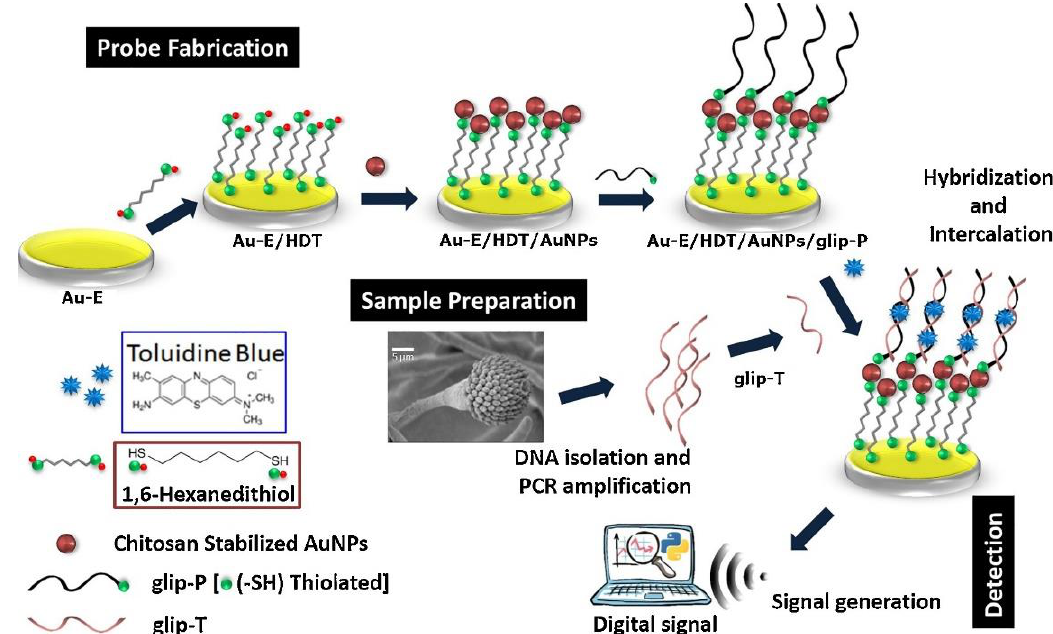
Figure 2. Fabrication and detection principle of glip biosensor. Initially, 1,6-hexanedithiol (HDT) is self-assembled onto a gold electrode (Au-E) to which chitosan-stabilised AuNPs (gold nanoparticles) are linked to the Au-E / HDT surface. Next, thiolated glip probes (glip-P) are allowed to react and are thereby immobilised onto the Au-E / HDT / AuNPs probe. Finally, the detection of the virulent glip target gene (glip-T) is achieved by hybridization followed by intercalation of toluidine blue that provides the analytical signal. Reprinted with permission from [124].